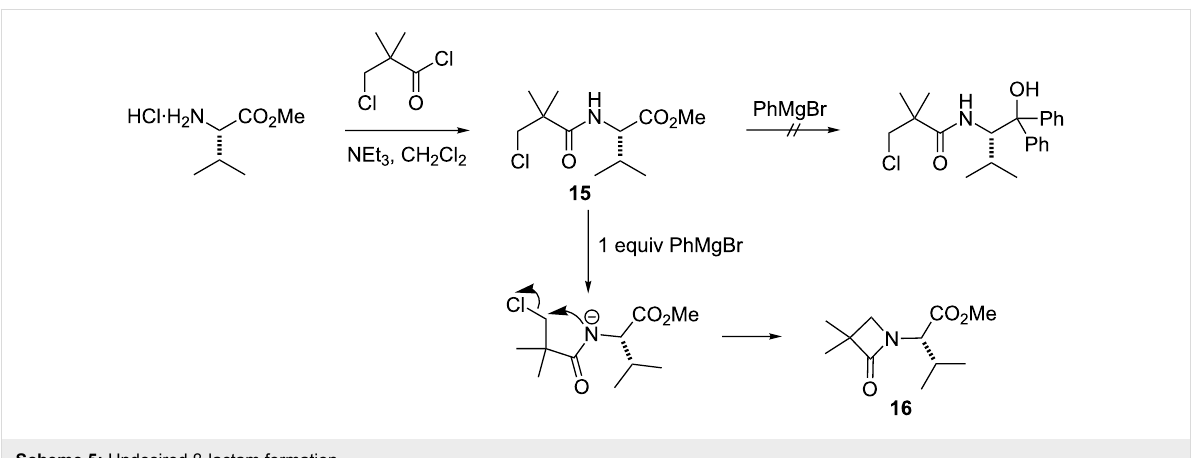
Scheme 5: Undesired β -lactam